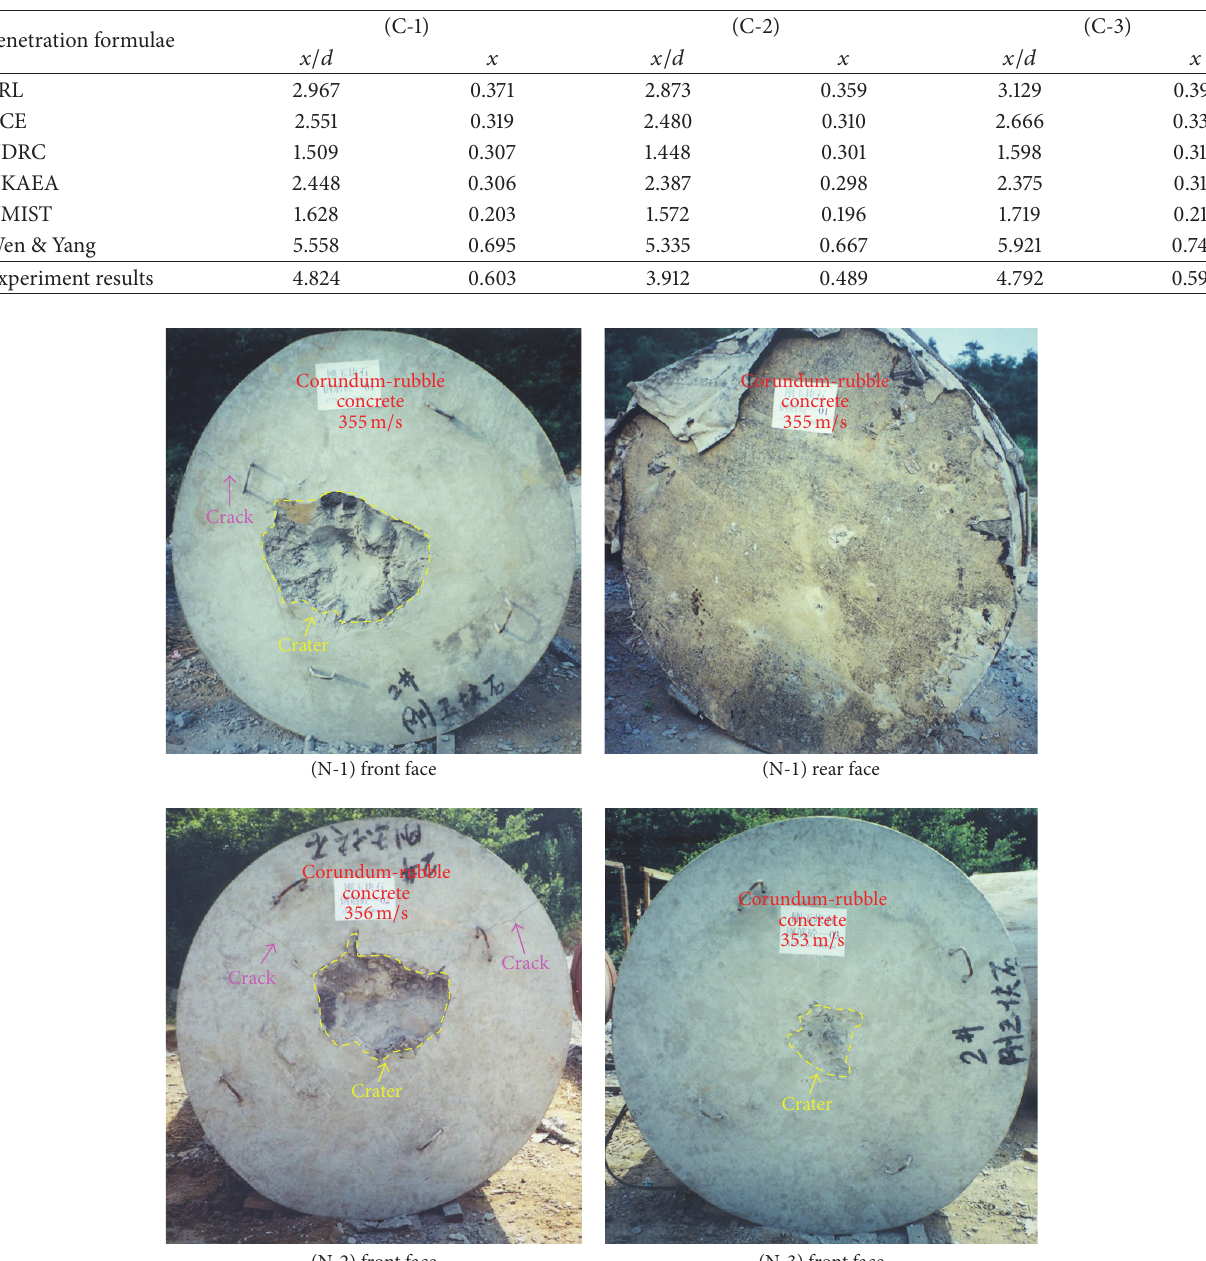
Table 4: Comparisons of various equations with the test data for the DOP of reinforced concrete.